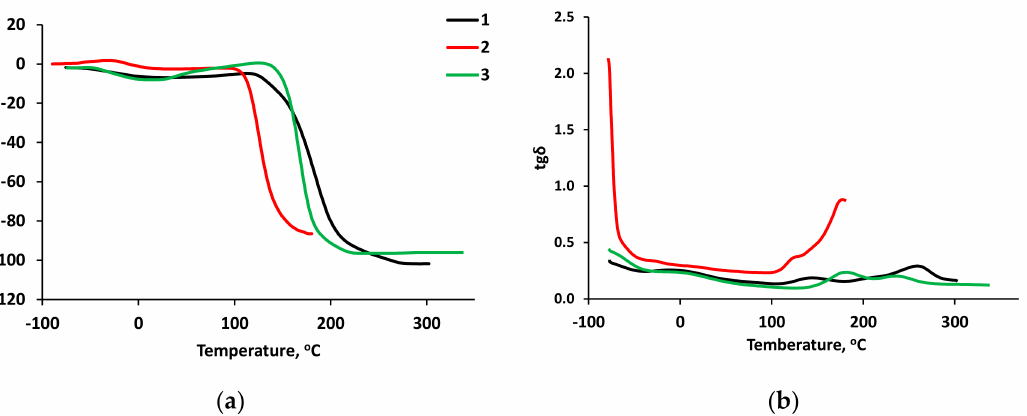
Figure 13. TMA curves ( a ) and temperature dependences of the mechanical loss tangent ( b ) of polymers based on [PPEG]:[TDI] = 1:8 (1) and [PPEG]:[D 4 ]:[TDI] = 1:15:8 obtained in the presence of [ASiP] = 0% (2), 0.2% (3)